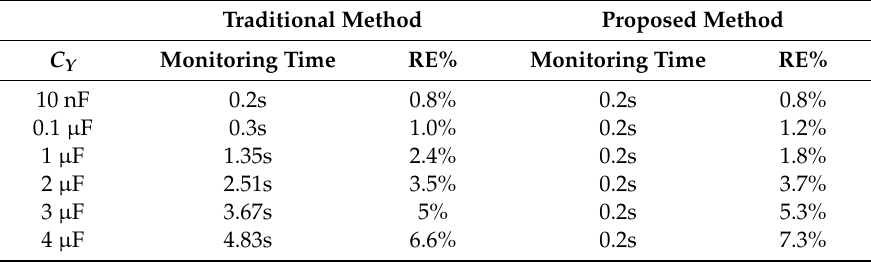
Table 3. Comparison of monitoring data in v dc = 800 V, R f 1 = 1000 k Ω , R f 2 = 300 k Ω .